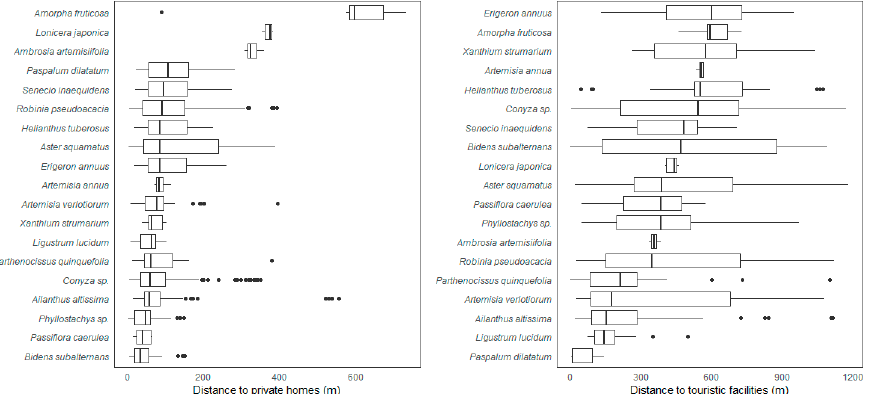
Figure 1. Boxplots indicating minimal, maximal, and median distance (together with outliers) of recorded alien plant taxa to private homes ( left ) and touristic facilities ( right ).